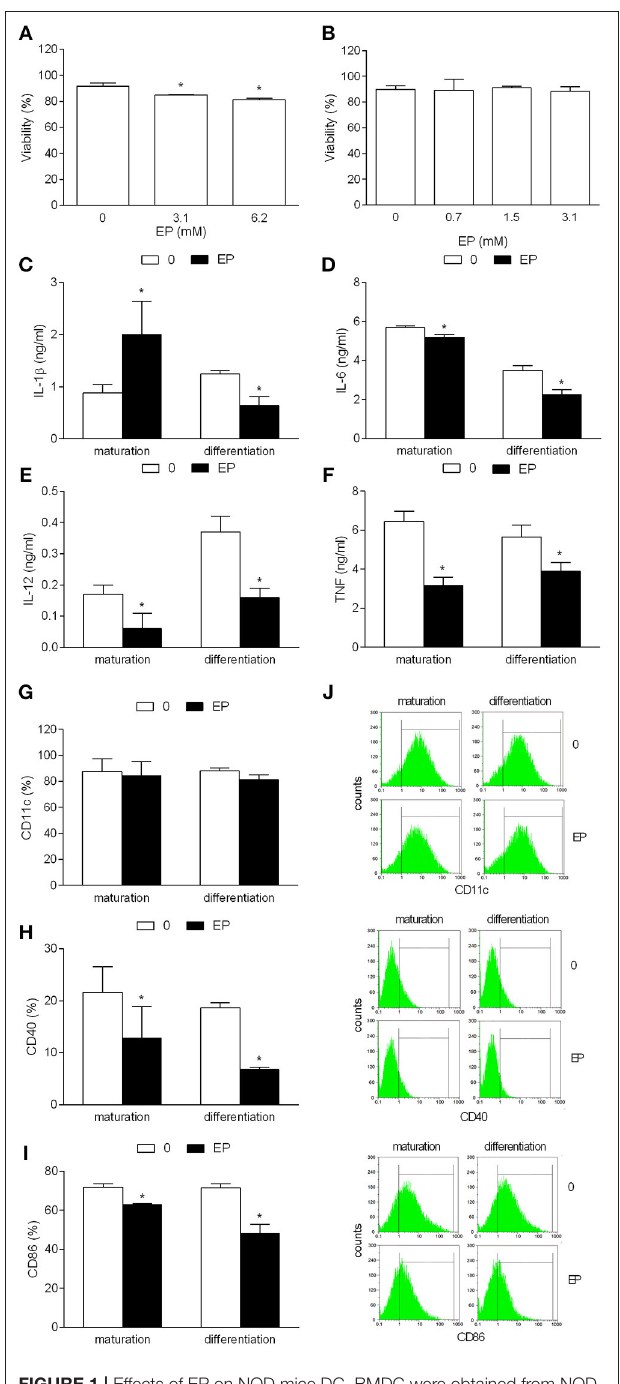
FIGURE 1 | Effects of EP on NOD mice DC. BMDC were obtained from NOD mice. They were treated with EP for 24h simultaneously with LPS ( A and “maturation”) or at days 3 and 6 of the propagation ( B and “differentiation”). 3.1mM EP was used in (C–I) . Viability (A,B) was determined by trypan blue exclusion assay. Cytokines were determined in cell culture supernatants by ELISA (C–F) . Proportion of cells expressing the listed antigens was determined by cytofluorimetry (G–J) . Data are presented as mean + SD from at least three independent experiments. Data in (J) are representative plots. * p < 0.05, EP vs. 0, one way ANOVA followed by Tukey’s multiple comparisons test (A,B) , two-tailed t -test (C–I)